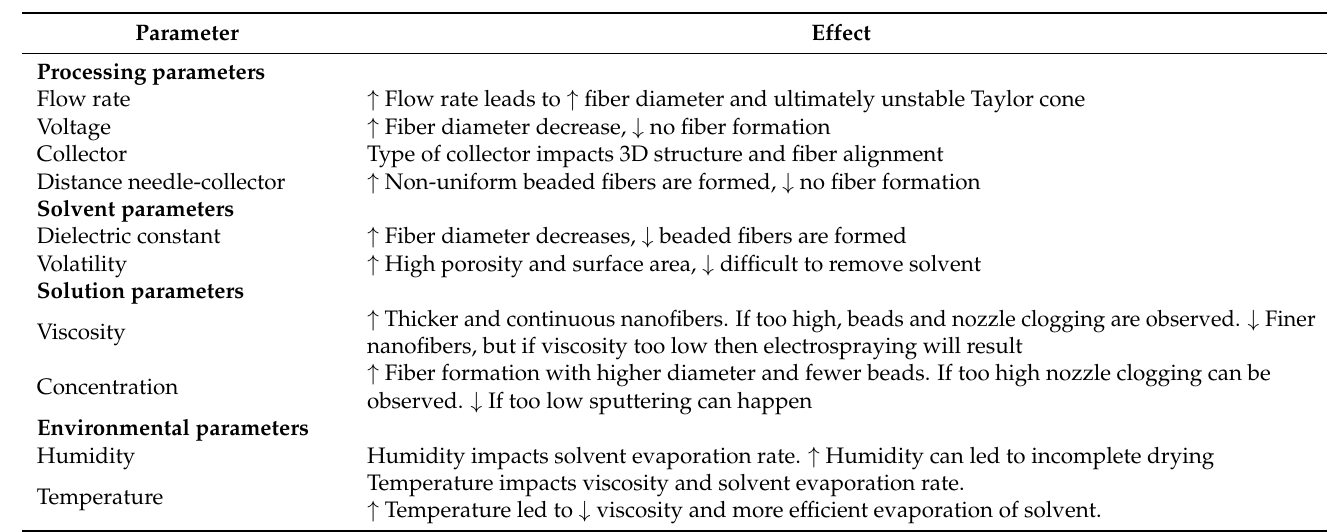
Table 1. Key factors affecting the electrospinning